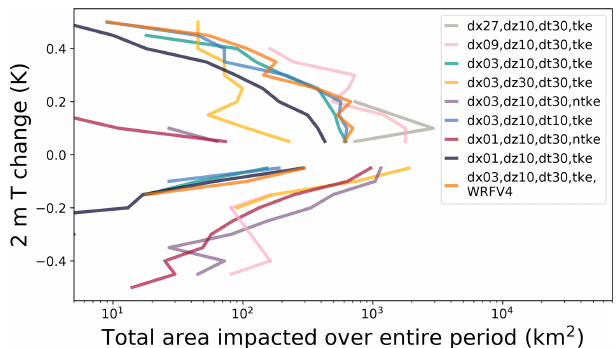
Figure 13. Total area impacted by the wake-induced 2m temper- ature change as predicted by the tested simulations, plotted at dif- ferent magnitudes of impact and integrated in time across the entire period. Each line is colored based on its configuration. Areas of warming are summed separately from areas of cooling.